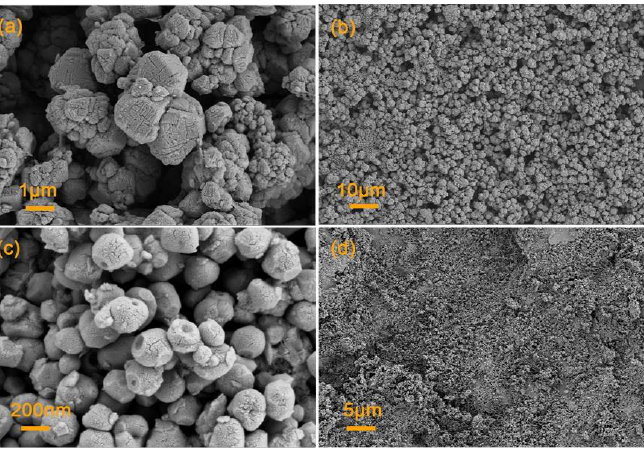
Figure 3. SEM images of ( a , b ) BiVO 4 and ( c , d ) Ag/BiVO 4 functionalized ceramic tiles obtained at 450 °C.